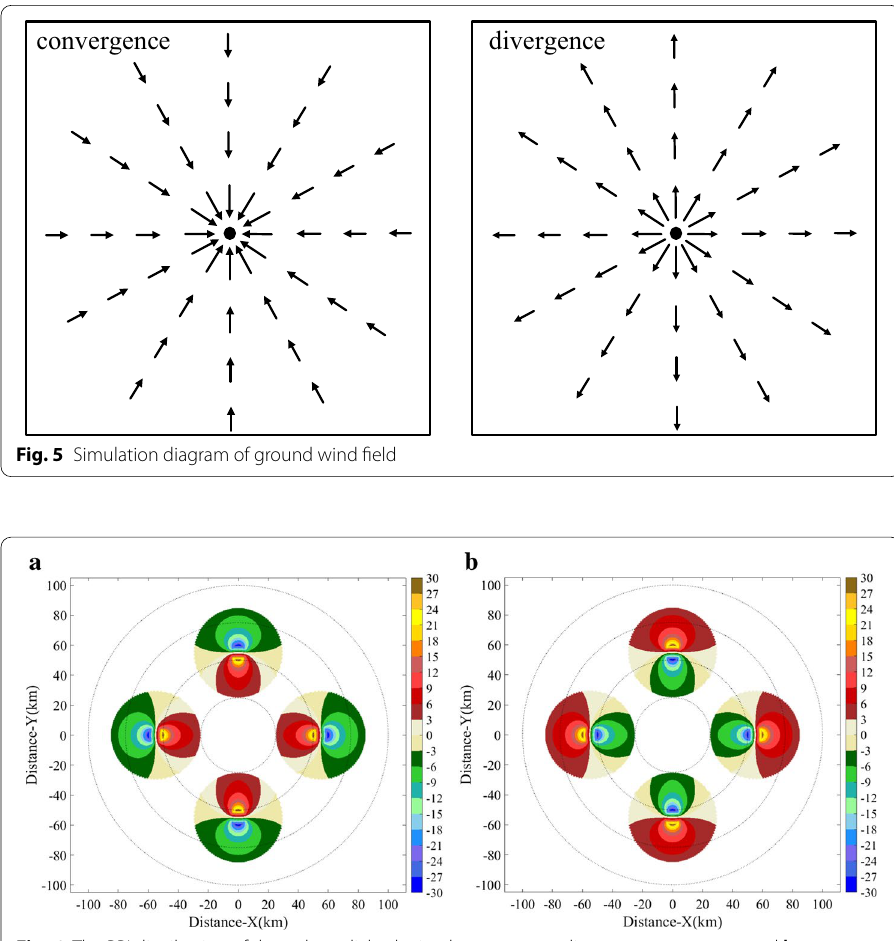
Fig. 6 The PPI distribution of the radar radial velocity data corresponding to a convergence and b